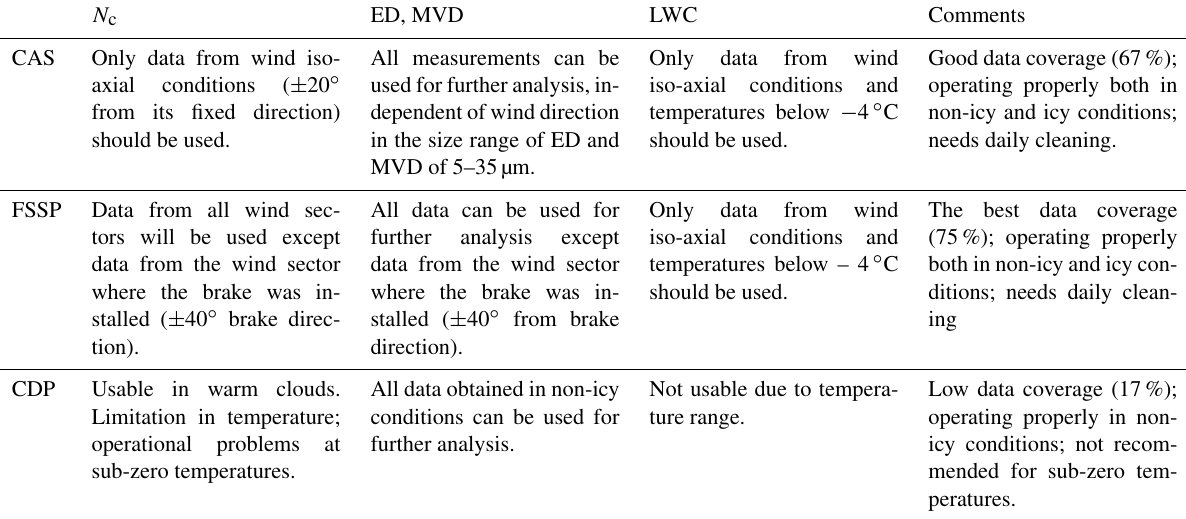
Table 2. The table presents the final recommendations for data analysis regarding the cloud spectrometers ground-based setups for future campaigns in sub-Arctic conditions with frequently occurring supercooled clouds. N c ED, MVD LWC